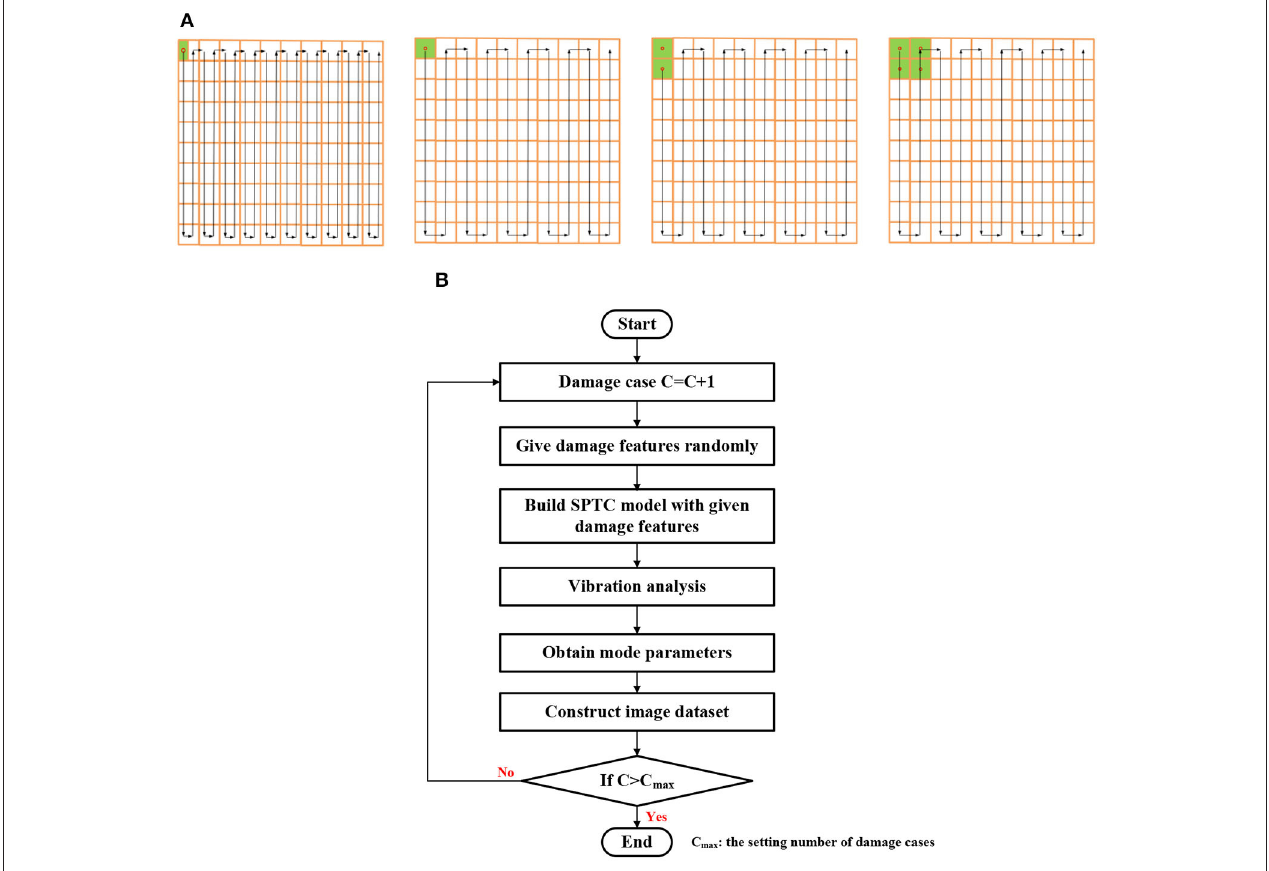
FIGURE 2 | Vibration analytical models of sandwich structure with truss core (SPTC). (A) Single-damage case. (B) Multiple-damage case.